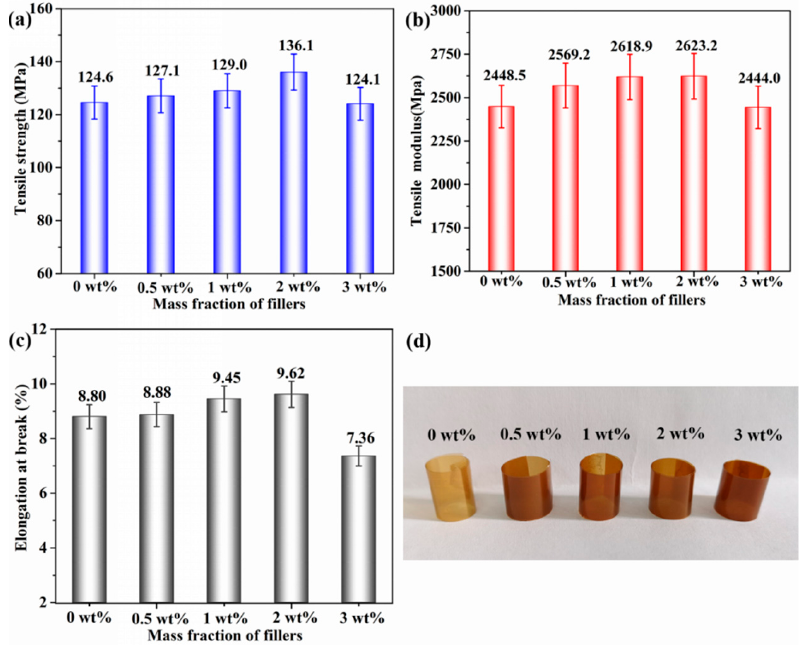
Figure 11. Tensile properties of h-BN@(PDA + PEI) / PEN: ( a ) tensile strength; ( b ) tensile modulus; ( c ) elongation at break and ( d ) photos of curled PEN nanocomposite films with various h-BN@(PDA + PEI) contents.